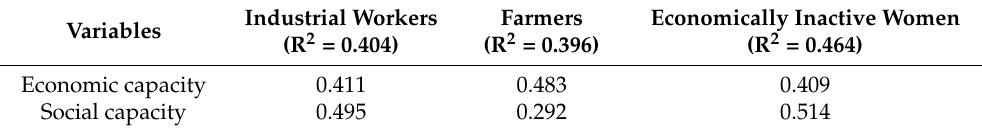
Table 9. Significant predictors of capacity component.